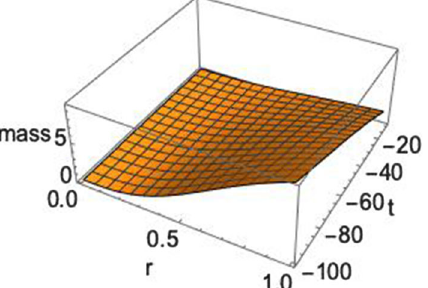
Fig. 1 Density as a function of the radial and temporal coordinates